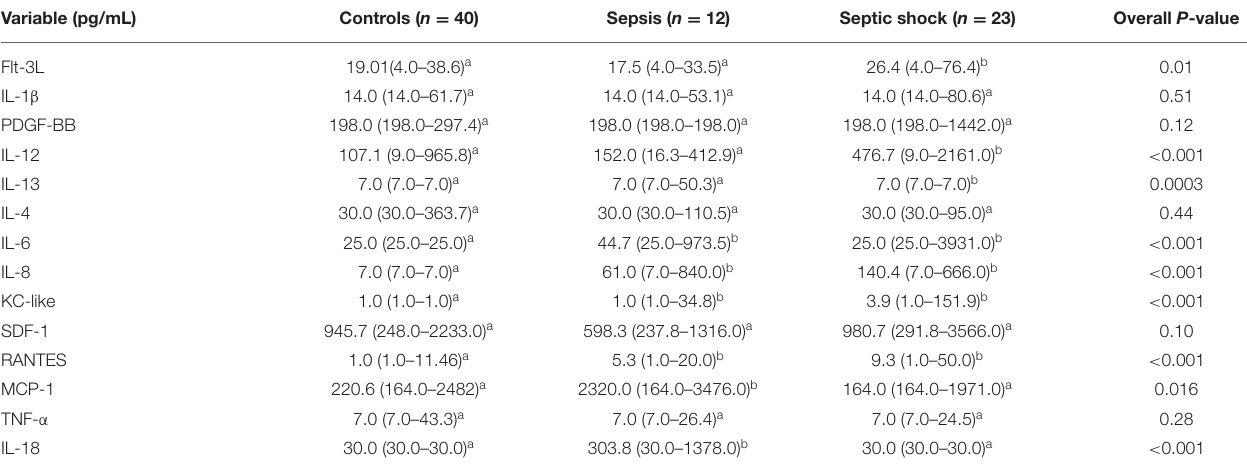
TABLE 2 | Comparison of plasma concentration of cytokines and chemokines healthy controls, cats with sepsis and cats with septic shock. Variable (pg/mL)